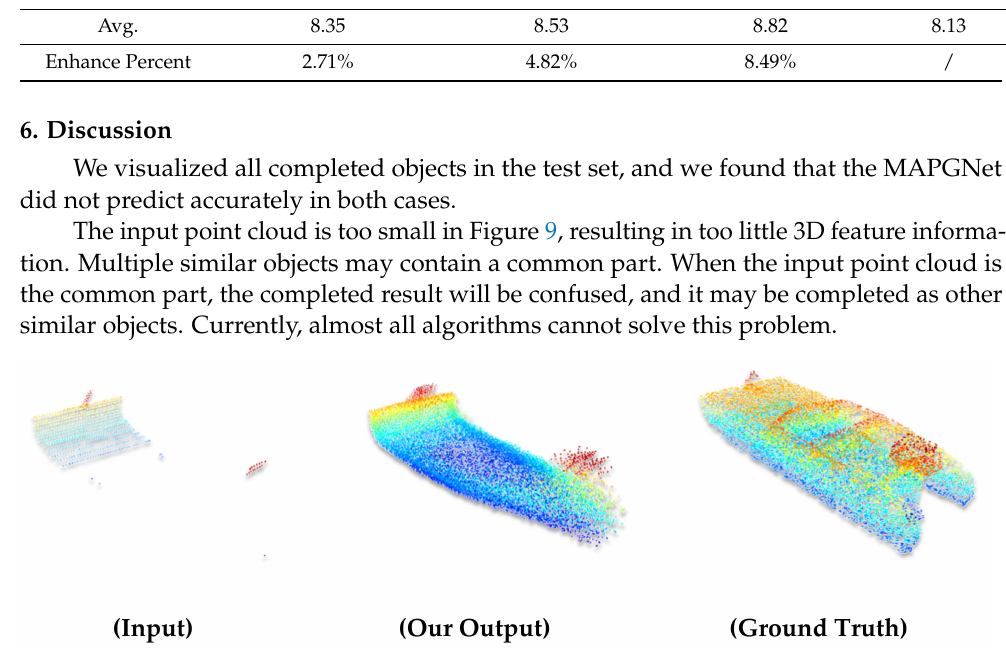
Figure 9. Failure example of the part of the input point cloud being too small.